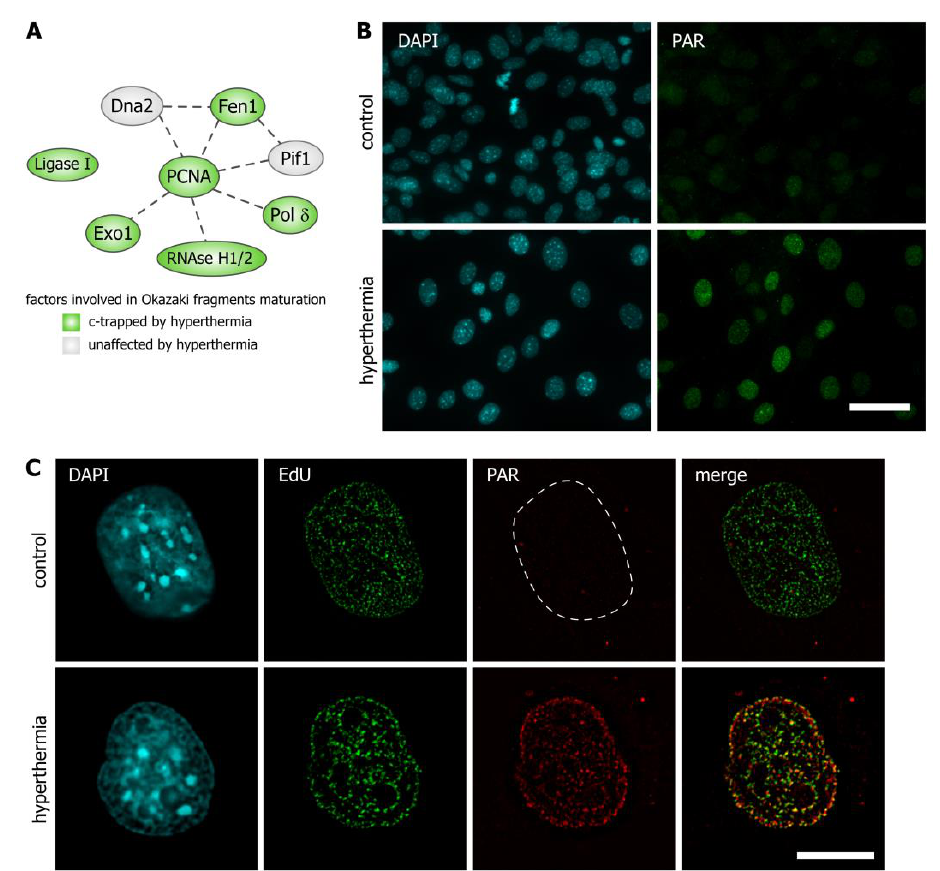
Figure 3. Hyperthermia induces DNA replication-associated poly(ADP-ribosyl)ation (PARylation). ( A ) The network of proteins involved in the maturation of Okazaki fragments in human cells. Proteins identified as c- trapped in response to hyperthermia are shown in green ellipses. ( B ) HEK293 cells were subjected to hyperthermia (45 °C, 30 min) and stained with antibodies against PAR. Control represents HEK293 cells that were not exposed to hyperthermia. The DNA was stained with 4,6-diamino-2-phenylindole (DAPI) (blue). Epifluorescence microscopy analysis was performed. Scale bar: 40 µm. ( C ) HEK293 cells were pulse-labeled with 5-ethynyl- 2’ -deoxyuridine (EdU) (10 µM, 30 min), subjected to hyperthermia (45 °C, 30 min) and stained with antibodies against PAR. Control represents untreated HEK293 cells. EdU was revealed by Click Chemistry; the DNA was stained with DAPI. Structured illumination microscopy (SIM) analysis was performed. Scale bar: 5 µm.